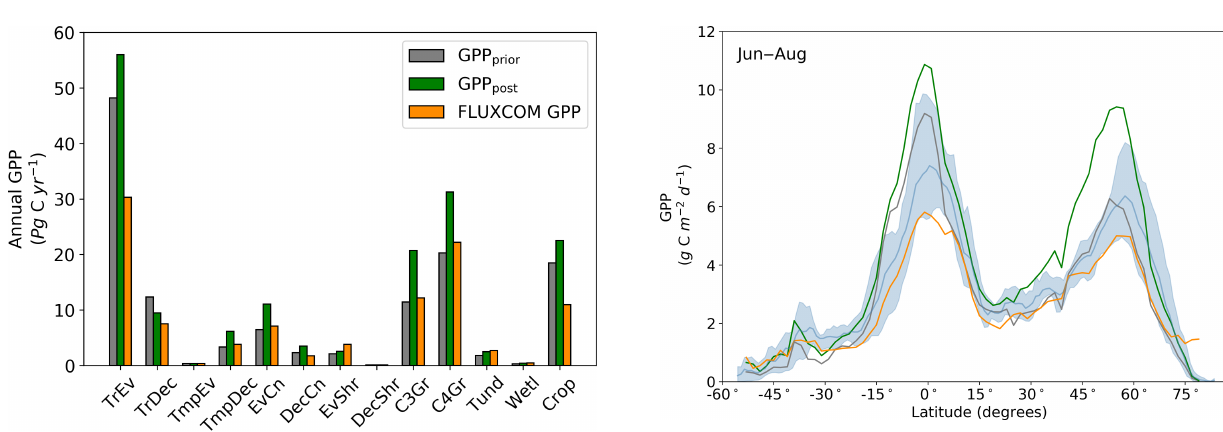
Figure 9. Annual GPP for 2015 per biome. Biomes are defined by aggregating model grid cells that have the same spatially dominant PFT as shown in the Fig. A1 in Appendix A.